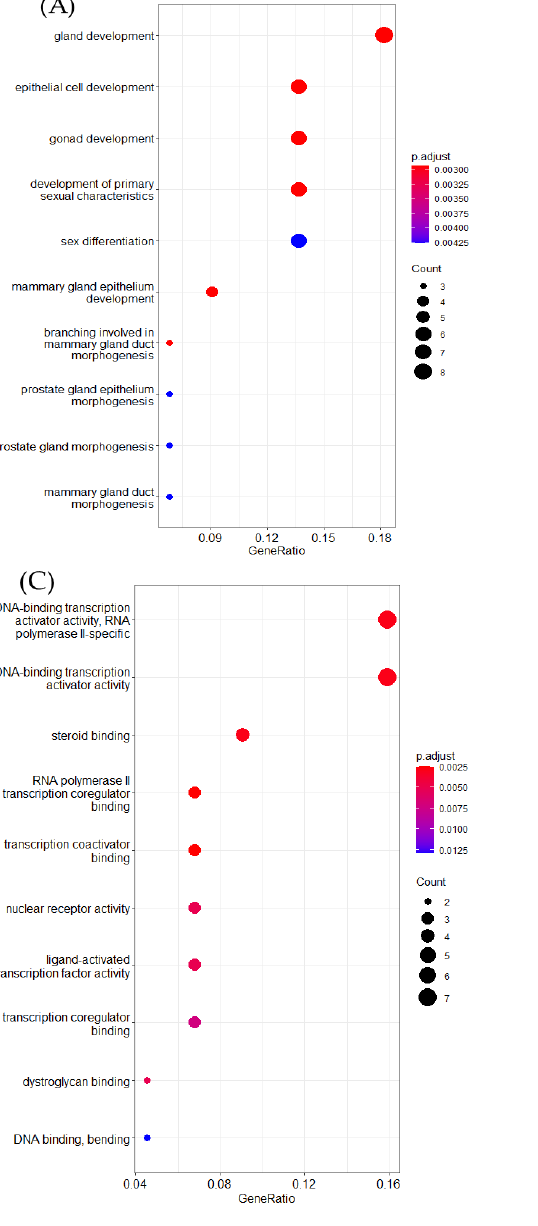
Figure 5. GO enrichment and KEGG enrichment analysis results. ( A ) Biological processes. ( B ) Cellular components. ( C ) Molecular functions. ( D ) KEGG enrichment.